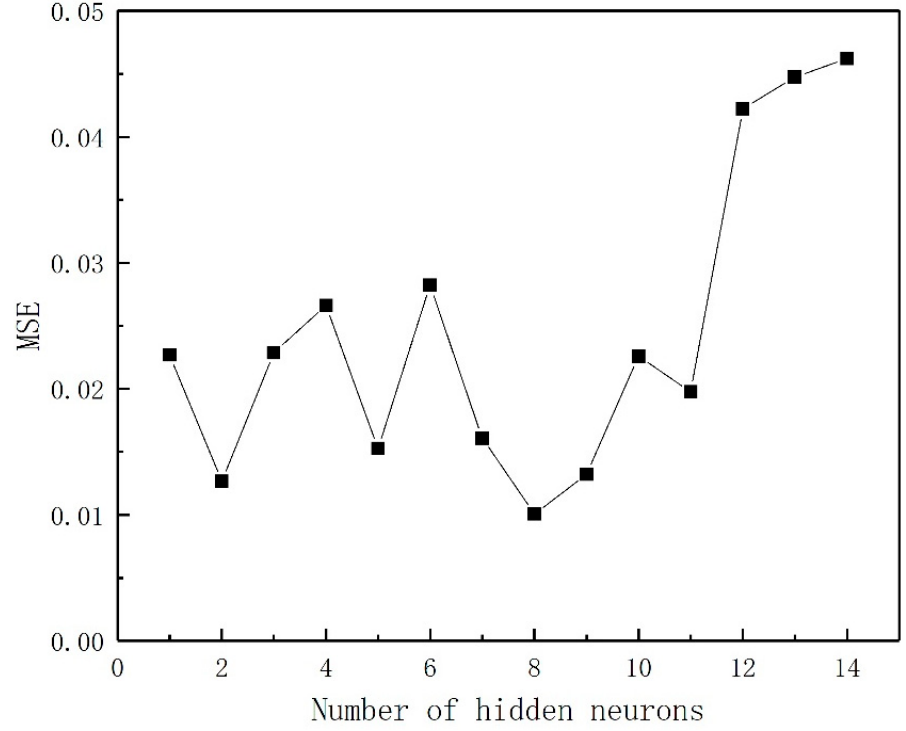
Figure 9. MSE (mean square error) plot for different numbers of neurons in the hidden layer (1–14) for the response of NH 4 + removal rate.